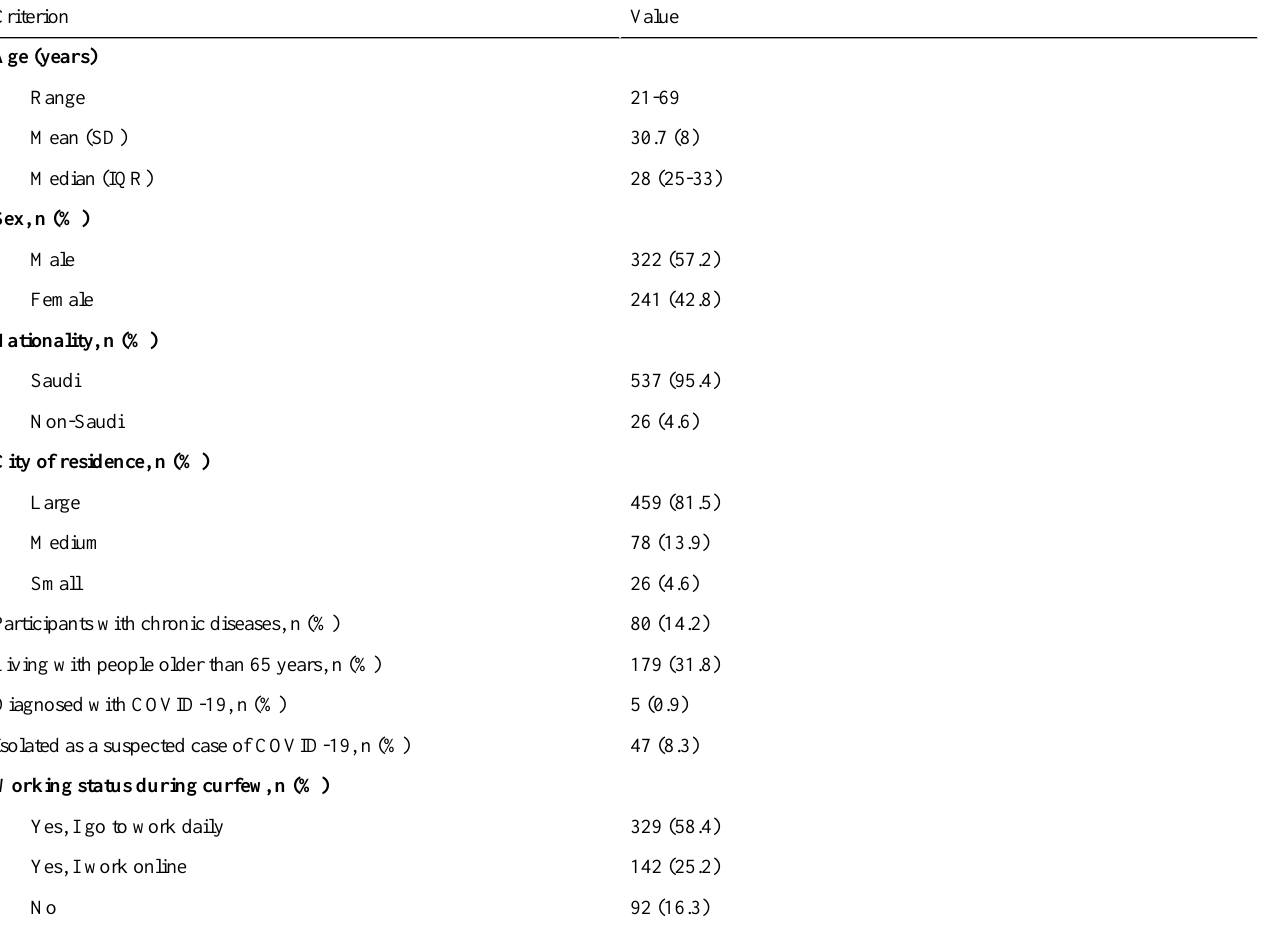
Table 1. Sociodemographic characteristics of health care workers in Saudi Arabia